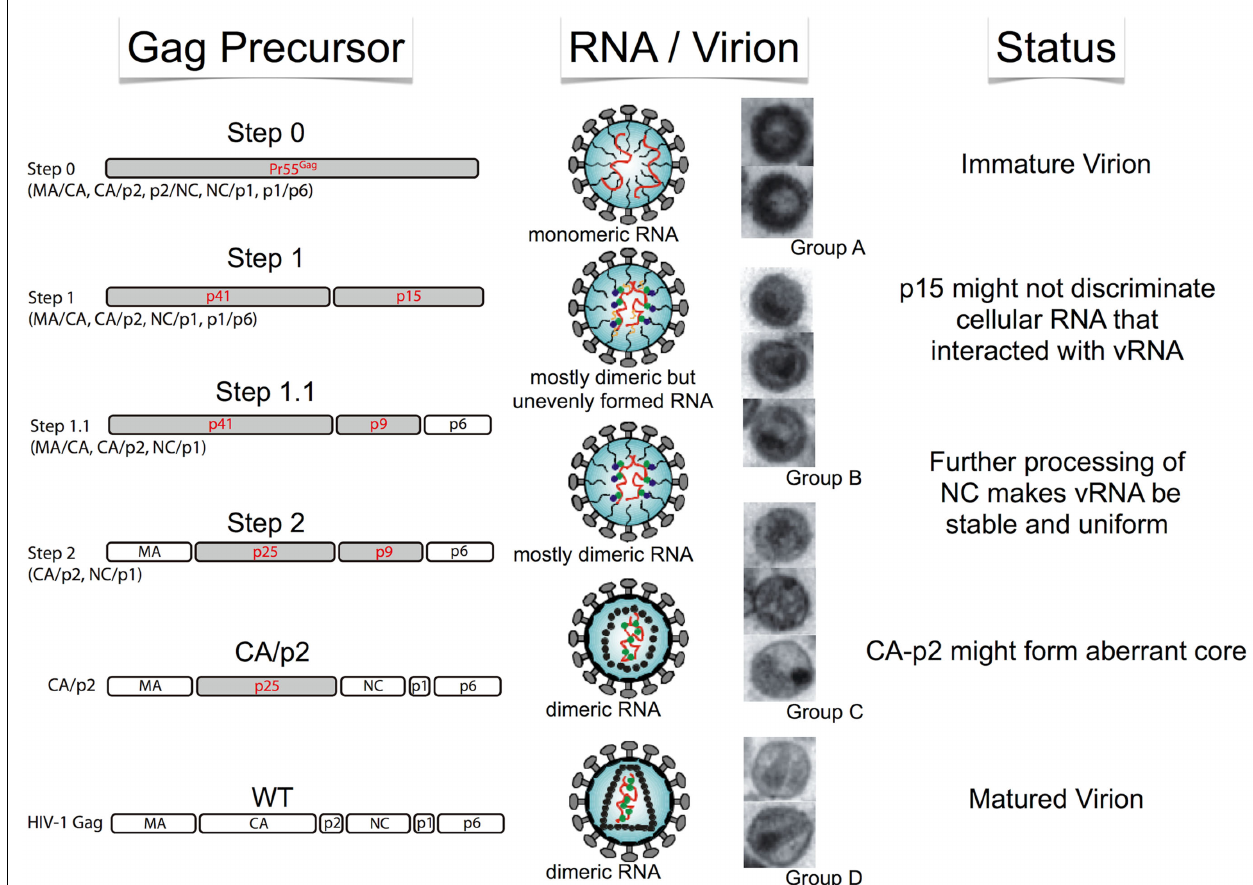
FIGURE 1 | Schematic of morphological and biological transition of the HIV-1 virion during maturation. Stepwise features of Gag cleavage, RNA status, and virion morphology are shown.